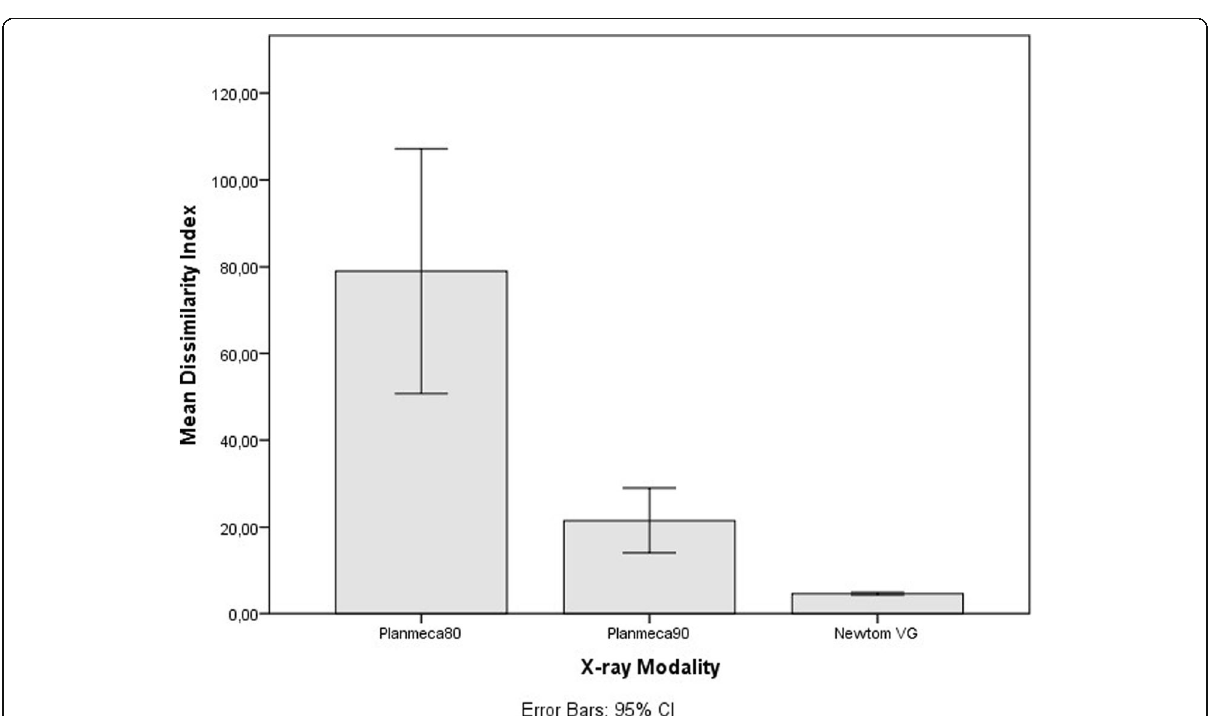
Fig. 3 Error per x-ray